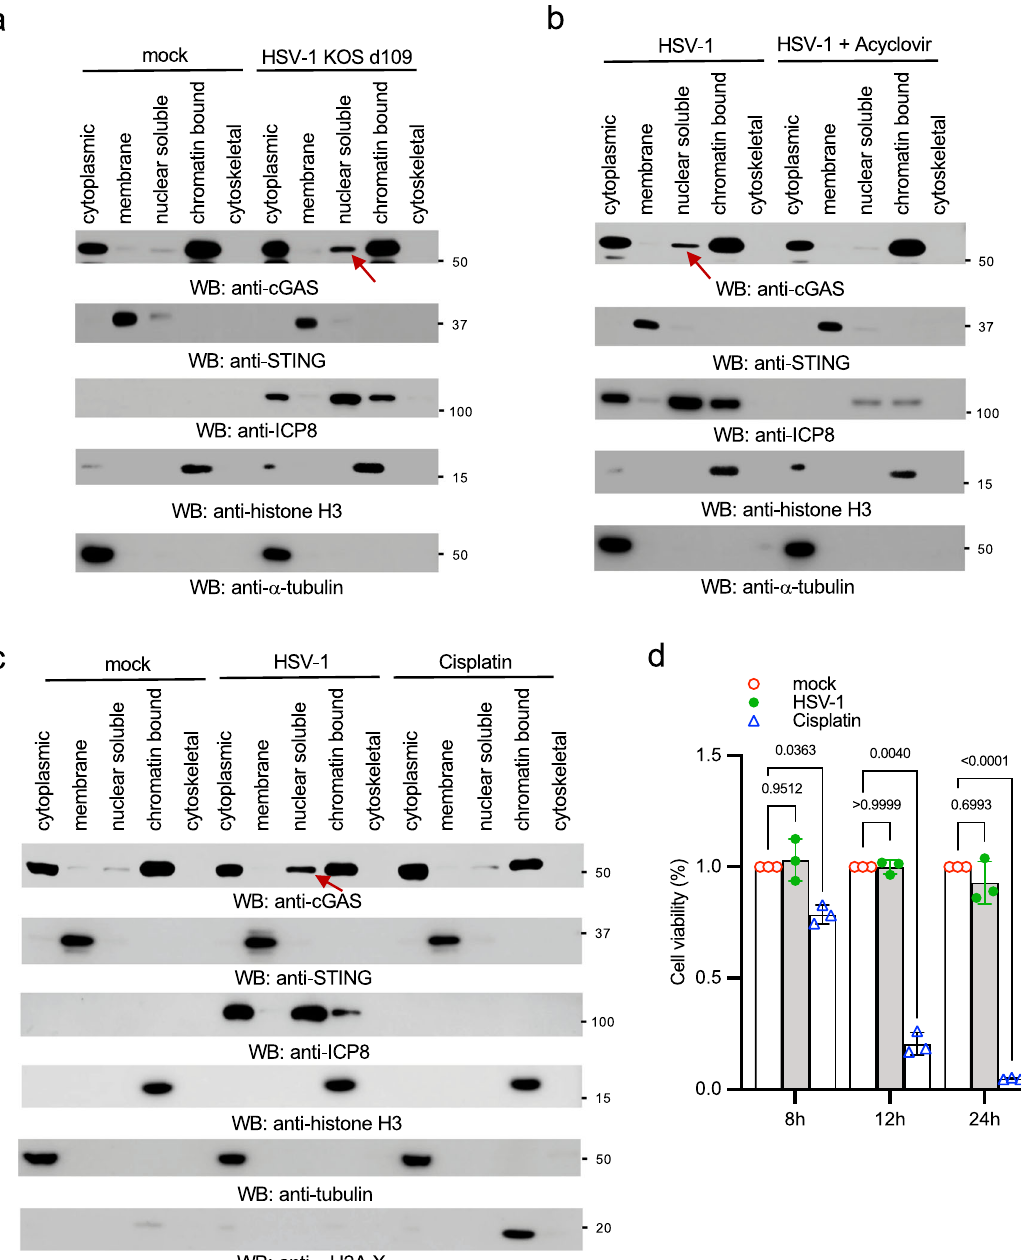
Fig. 3 Inhibition of HSV-1 replication blocks cGAS release from the chromatin. a RAW 264.7 cells were mock-infected or infected with 1 MOI of HSV-1 KOS d109 for 16 h. Cell lysates were fractionated and blotted as indicated. b RAW 264.7 cells were pretreated without or with 8 μ g/mL of acyclovir for 16 h, followed by infection with 1 MOI of HSV-1 McKrae for 12 h. Cell lysates were fractionated and blotted as indicated. The arrow indicates nuclear soluble cGAS. c RAW 264.7 macrophages were treated with dimethylformamide (DMF) as a vehicle mock control, 50 μ M cisplatin for 4 h, or infected with HSV-1 McKrae for 12 h. Cell lysates were fractionated and blotted as indicated. The arrow indicates nuclear soluble cGAS. STING: membrane marker; α -tubulin: cytosolic marker; H3: nuclear marker; ICP8: HSV-1 viral protein; γ -H2A.X: DNA damage marker. The arrow indicates nuclear soluble cGAS. d RAW 264.7 macrophages were treated with DMF (mock control), 50 μ M cisplatin or infected with HSV-1 McKrae for indicated times. Then, cell viability was determined by MTT assays. Data represent means ± s.d. of three independent experiments. The P -value was calculated by two-way ANOVA followed by Sidak ’ s multiple comparisons to activate innate immune response in KO(LL/RK-NLS) (Fig. 5b, c and Supplementary Fig. 5a). The reconstitution of RAW264.7 macrophages (Supplementary Fig. 5b), suggesting that cGAS and LL/RK-NLS also rescued TBK1 phosphorylation, the nuclear cGAS is activated by HSV-1 infection, but not cytosolic hallmark of activation of IFN production pathways, in cGAS DNA. knockout cells (Fig. 5d). Furthermore, KO(LL/RK-NLS) Next, we examined whether cGAS enzymatic activity was RAW264.7 cells produced a signi fi cant amount of cGAMP after required for nuclear soluble cGAS-mediated innate immune HSV-1 infection (Fig. 5e). By contrast, transfected ctDNA failed